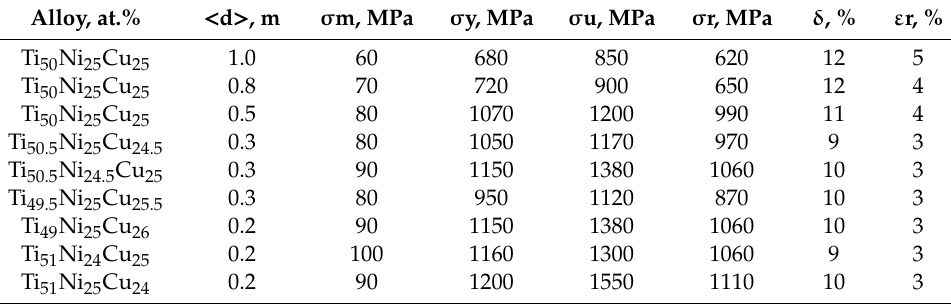
Table 10. Mechanical properties of RQM alloys of the Ti–Ni–Cu system. Alloy, at.%